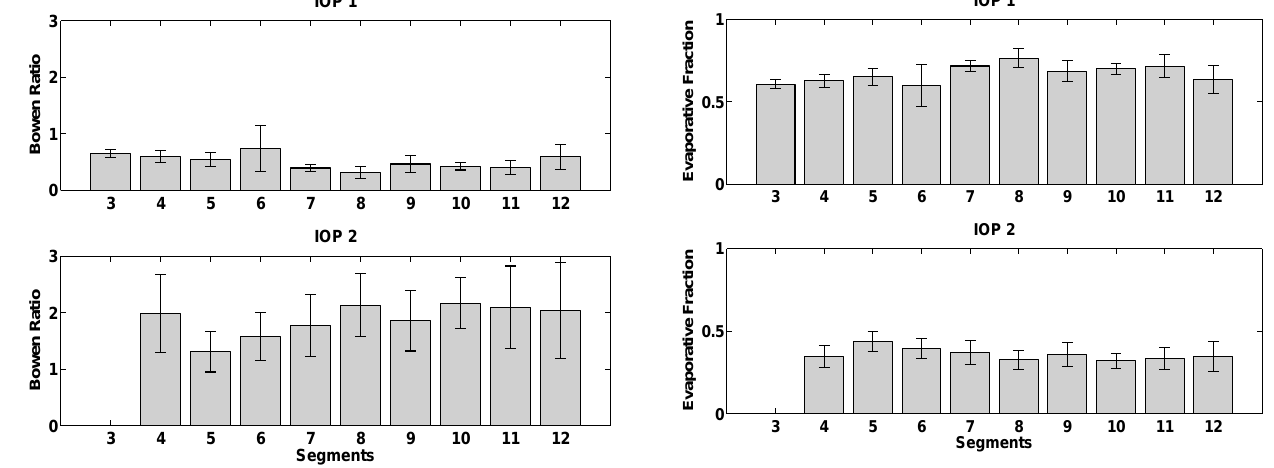
Fig. 7. Average Bowen ratio per segment with error bars (= stan- dard deviation of single passes) along flight track during IOP1 (18– 22 April) and IOP2 (7–14 September) at CERES’07.